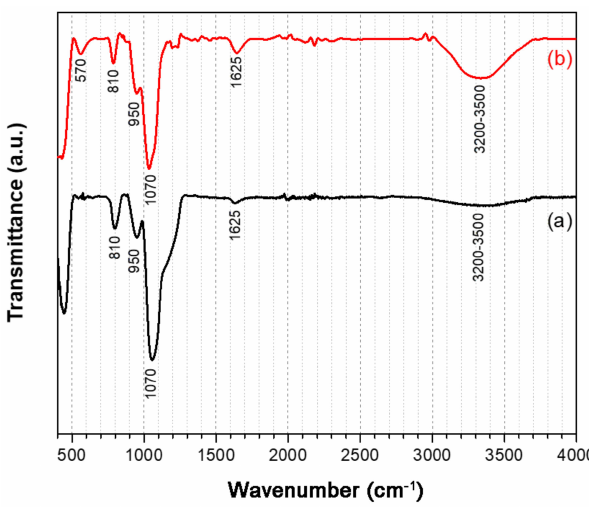
Figure 7. FT-IR spectra of ( a ) pristine silica microspheres and ( b ) Fe + —functionalized silica